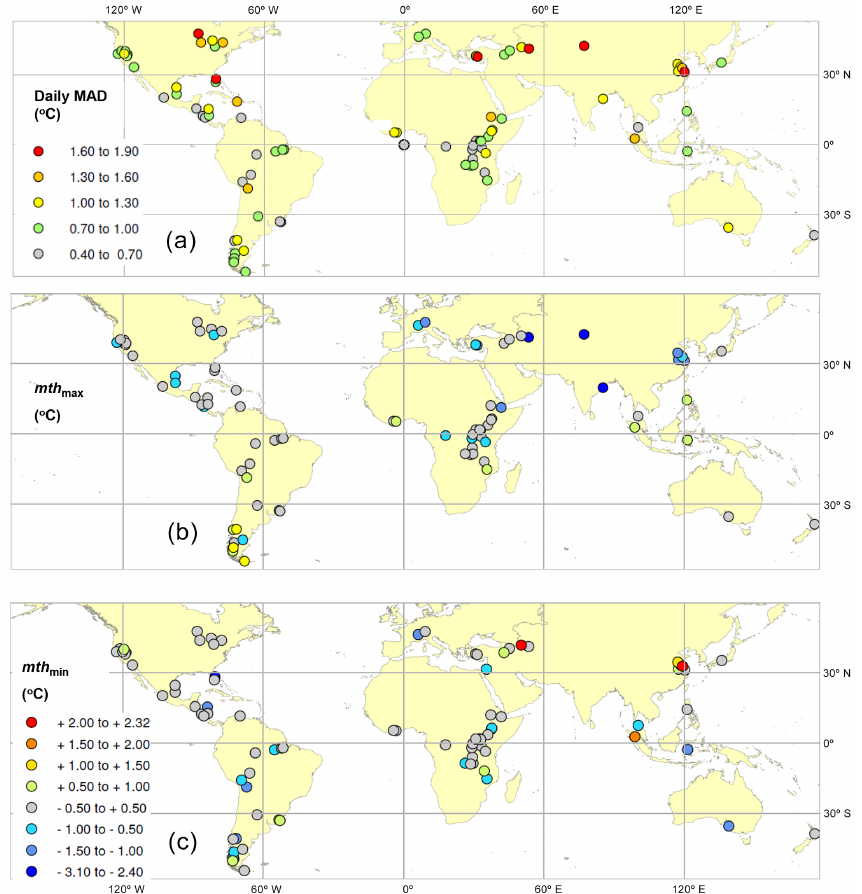
Figure 13. Tuning metric results for the 84 non-ice-covered lakes (a) daily mean absolute difference (MAD) between observed and modelled LSWTs, (b) mth max and (c) mth min . mth min (and mth max ) is the difference between the observed and modelled LSWTs for the month where the minimum (and maximum) LSWT is